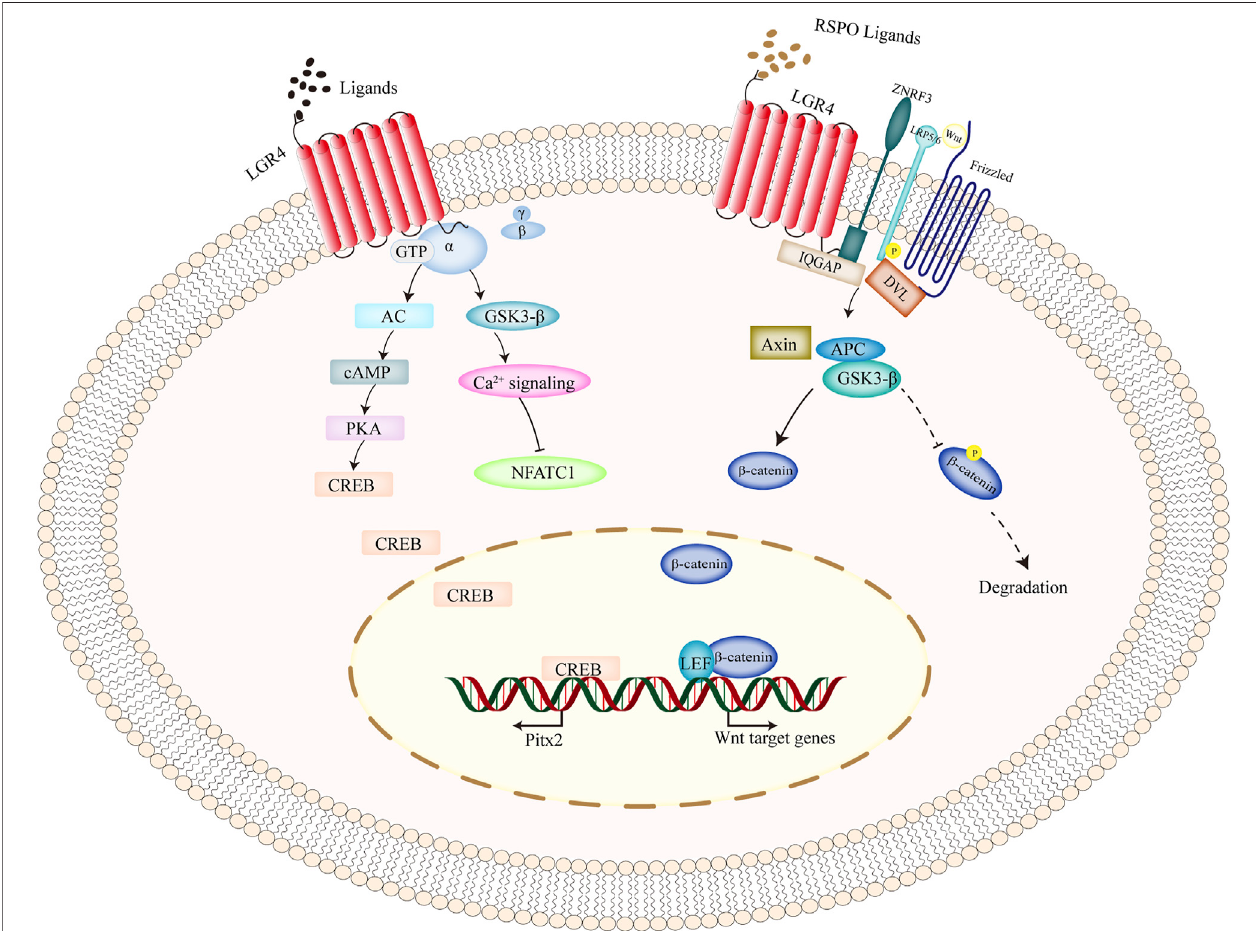
FIGURE 2 | Intracellular signaling pathways of LGR4 gene. As a classical GPCRs molecule, upon ligands binding to LGR4, and it activated heterotrimeric G-proteins to transduce the cytoplasmic signal. Moreover, upon the stimulation of RSPO ligands, simultaneous binding of ZNRF3 and LGR4 suppressed the ubiquitination of frizzled receptor, promoted LRP phosphorylation, recruited IQGAP1 and increased its interaction with DVL, and thus activating the canonical Wnt signaling. β -catenin was prevented from degradation, translocated into the nucleus, and interacted with the transcription factors of TCF/LEF to induce the transcription of its target genes. Abbreviations: GPCRs, G-protein-coupled receptors; LGR4, leucine-rich repeat-containing G protein-coupled receptor 4; RSPO,